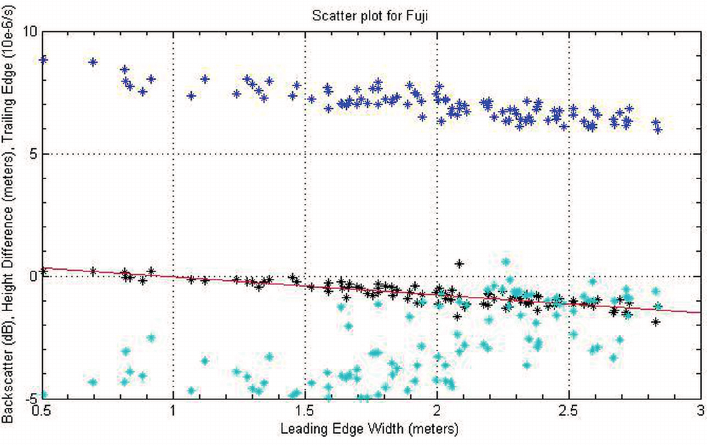
Figure 6. Scatter plot between the leading edge width from ENVISAT and the elevation difference between ICEsat and ENVISAT in meters (black stars) for the Dronning Maud Land area where the penetration bias can be considered prevailing: Dome Fuji.